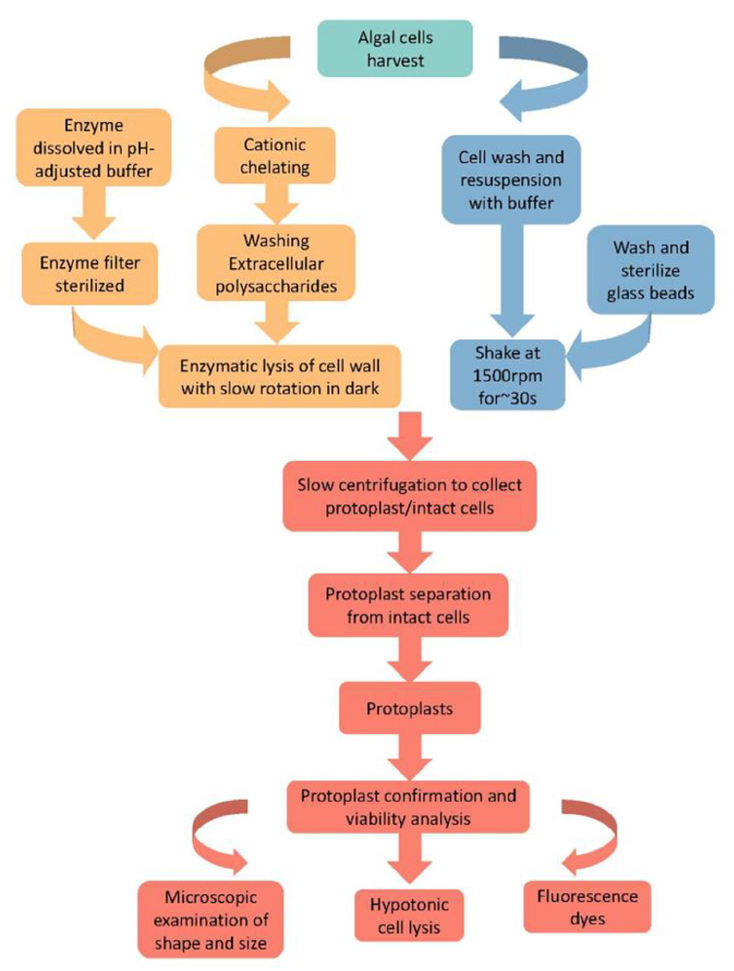
Figure 4. General protocols for protoplast isolation from algal cells. The protocol is mainly composed of five steps, including enzyme solution preparation, cell preparation, chelator treatment, enzymolysis, protoplast collection, and protoplast confirmation and viability analysis.